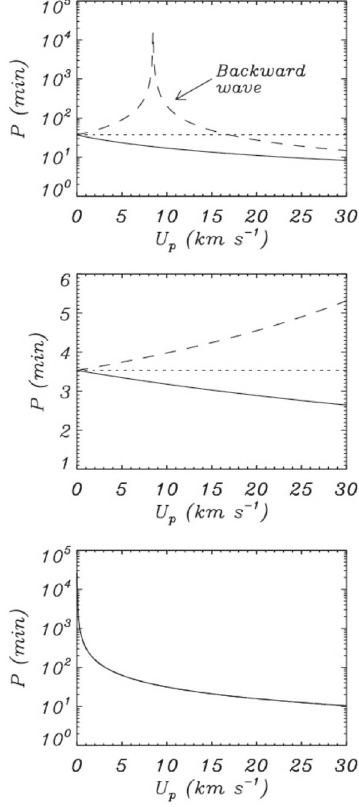
Fig. 45 Period of the fundamental oscillatory modes of an infinitely long thread versus the mass flow, U p . The top, middle and bottom panels correspond to the slow, kink and thermal modes. Different line styles correspond to waves propagating in the absence of flow (dotted), parallel waves (solid) and anti-parallel waves (dashed). The wavenumber is given by k z a = 10 − 2 , which is consistent with the wavelength of observed propagating waves in prominences (Sect. 5.9); a is the thread radius. Image reproduced with permission from Soler et al.